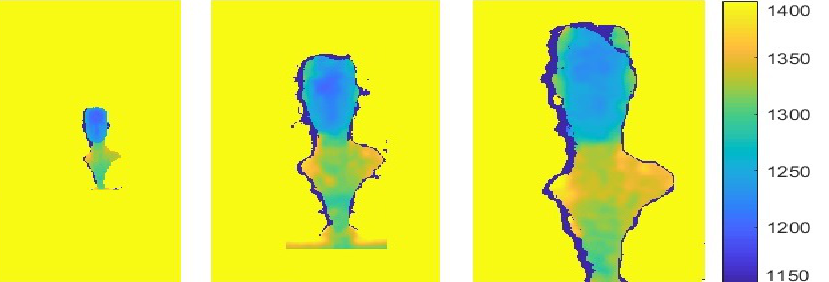
Figure 19. The same object captured by three different depth cameras positioned at the same distance from the camera. Shadow size in pixels (left to right): Kinect V1 (3), Intel D435 (8) and Intel D415